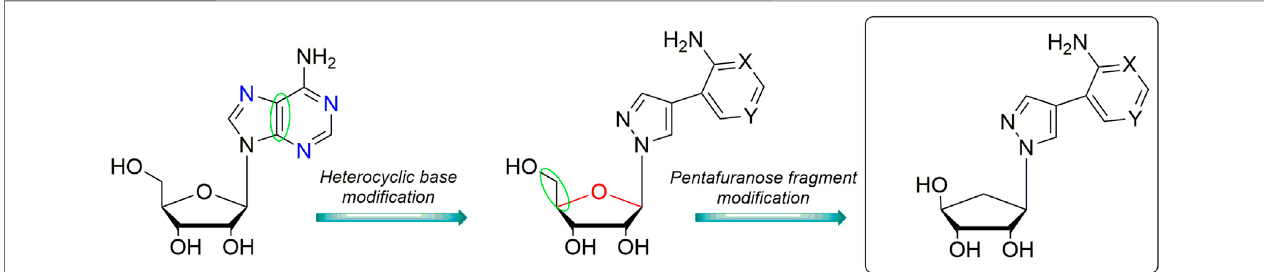
FIGURE 1 | Design of 5 ′ -norcarbocyclic aza/deaza-purine fl eximers.